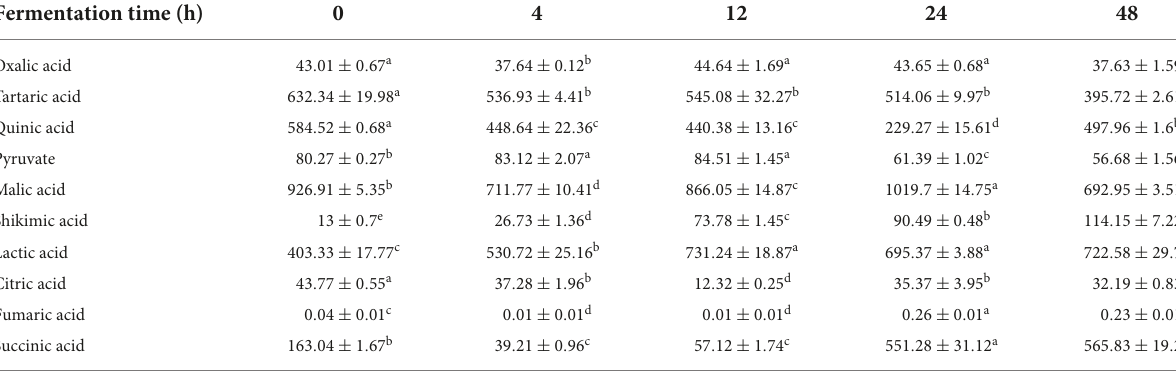
TABLE 3 Changes in the content of different organic acids during fermentation ( µ